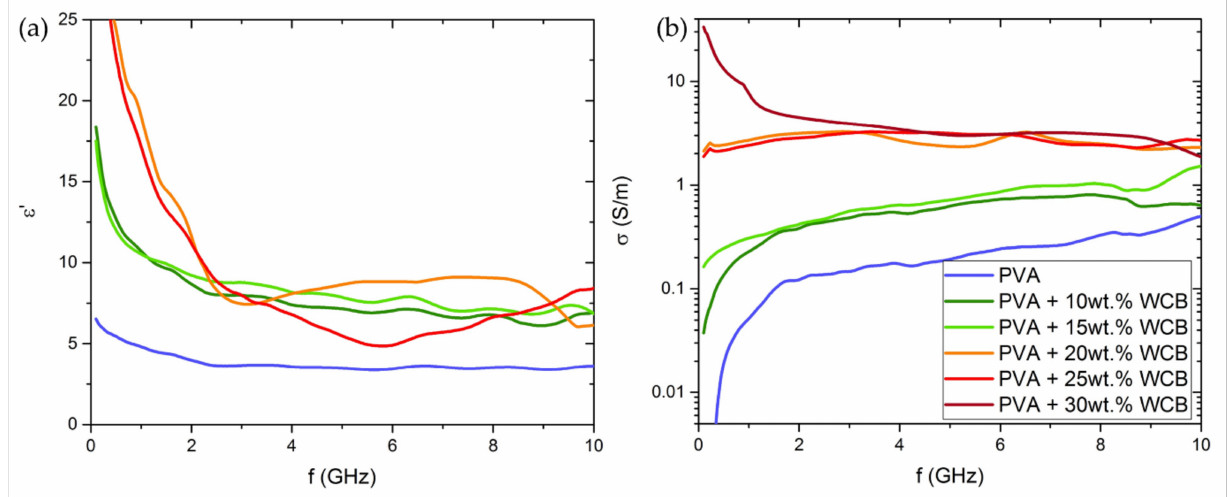
Figure 5. Electrical measurements as a function of frequency of WCB composites showing the trend of ( a ) complex dielectric permittivity and ( b ) electrical conductivity (logarithmic scale) from 0.1 GHz up to 10 GHz.